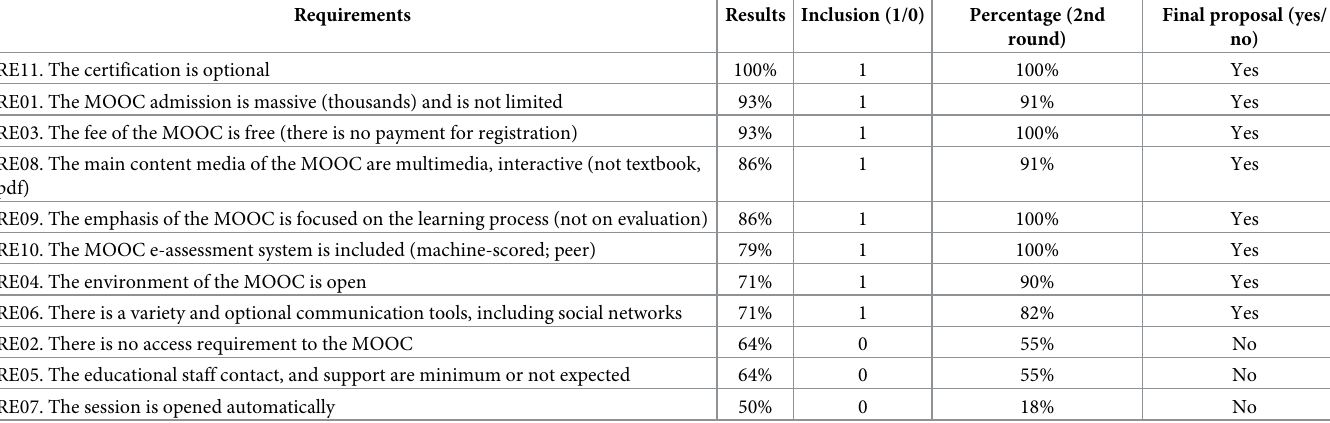
Table 2. Requirements results of the Delphi